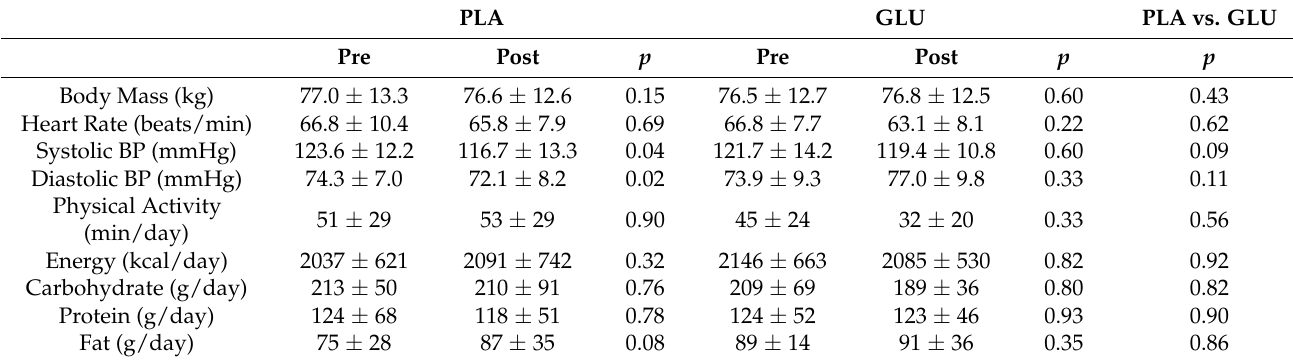
Table 1. Participant Demographics, Hemodynamics, and Dietary